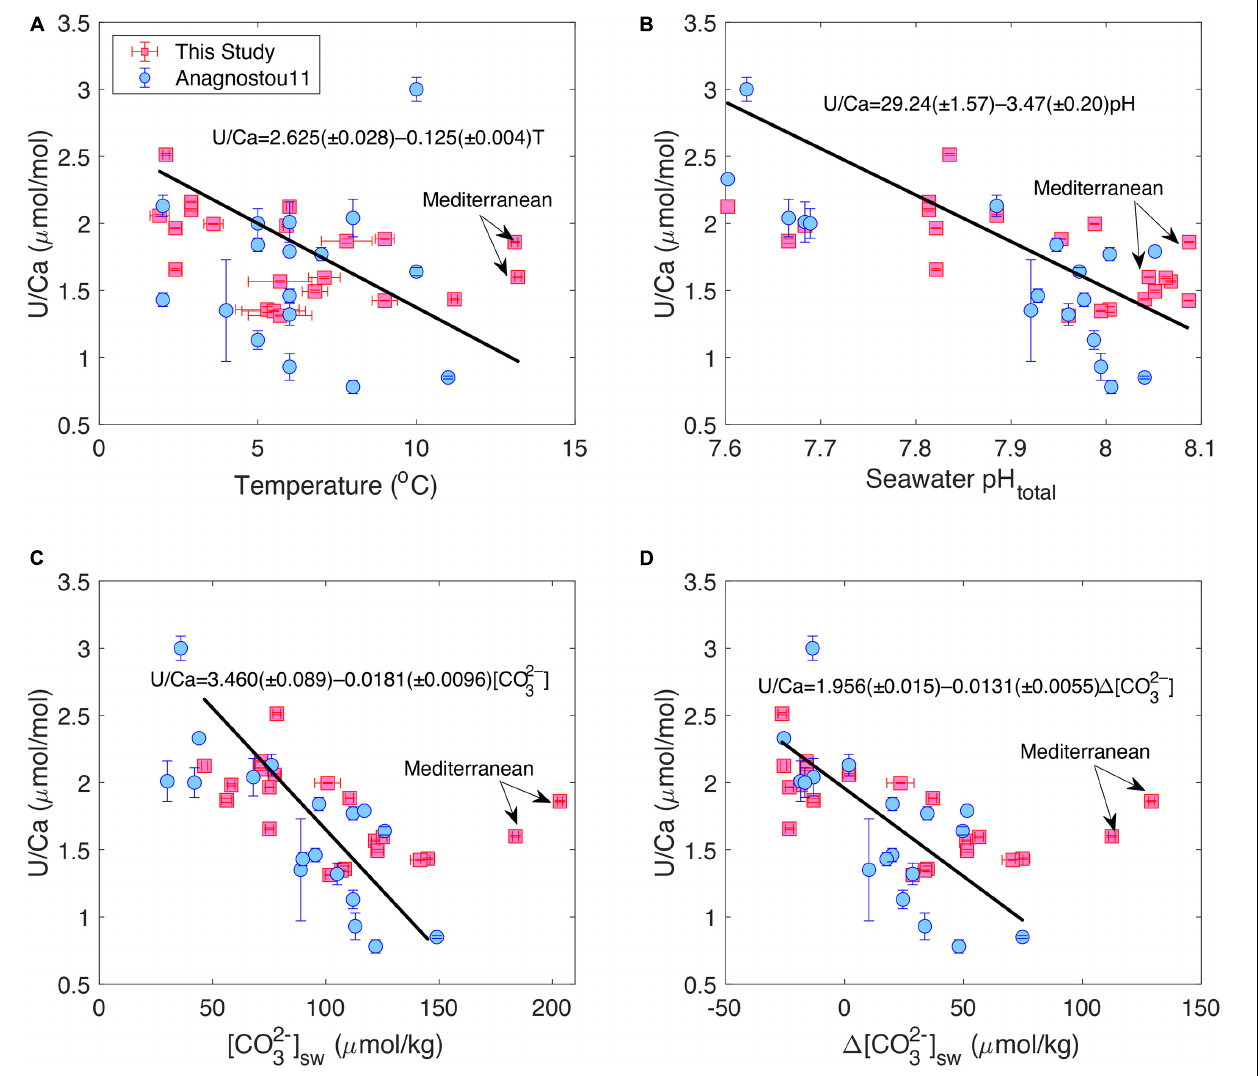
FIGURE 1 | Correlations between bulk D. dianthus U/Ca with (A) temperature, (B) seawater pH, (C) seawater [CO 32 − ], and (D) (cid:49) [CO 32 − ]. Red squares are from this study and blue circles are from Anagnostou et al. (2011) with 1 σ error bars. The black lines show linear fits to the data in this study considering uncertainties in both environmental estimates and U/Ca measurements following York et al. (2004). Two corals from the Mediterranean Sea are excluded from the linear